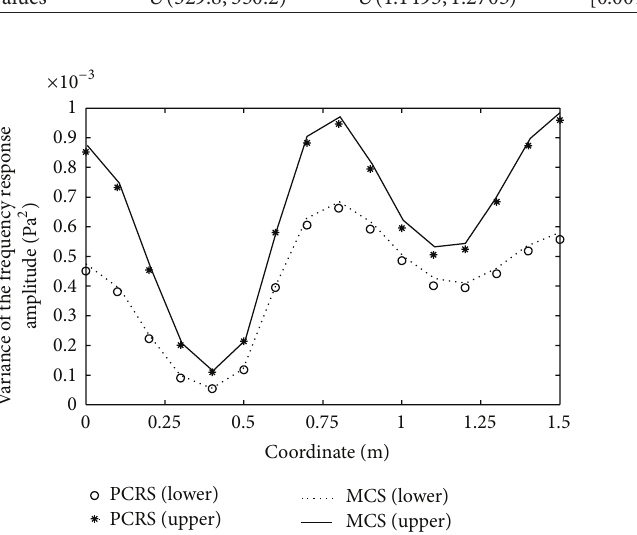
Figure 6: The lower and upper bounds of variance of the frequency response amplitude at uncertain level 5%.